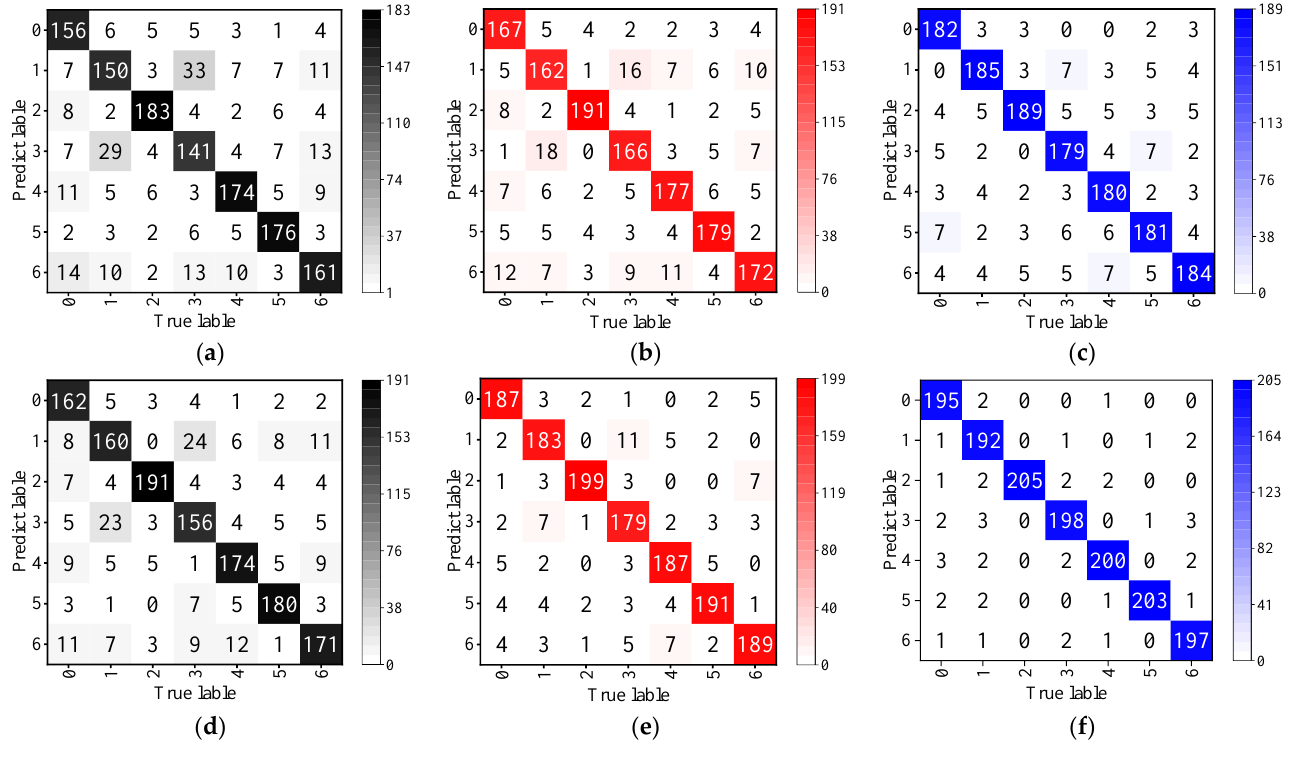
Figure 15. The confusion matrix of different models: ( a ) The confusion matrix of PSO-1DCNN; ( b ) The confusion matrix of PSO-2DCNN; ( c ) The confusion matrix of PSO-FCNN; ( d ) The confusion matrix of MSPSO-1DCNN; ( e ) The confusion matrix of MSPSO-2DCNN; ( f ) The confusion matrix of MSPSO-FCNN.